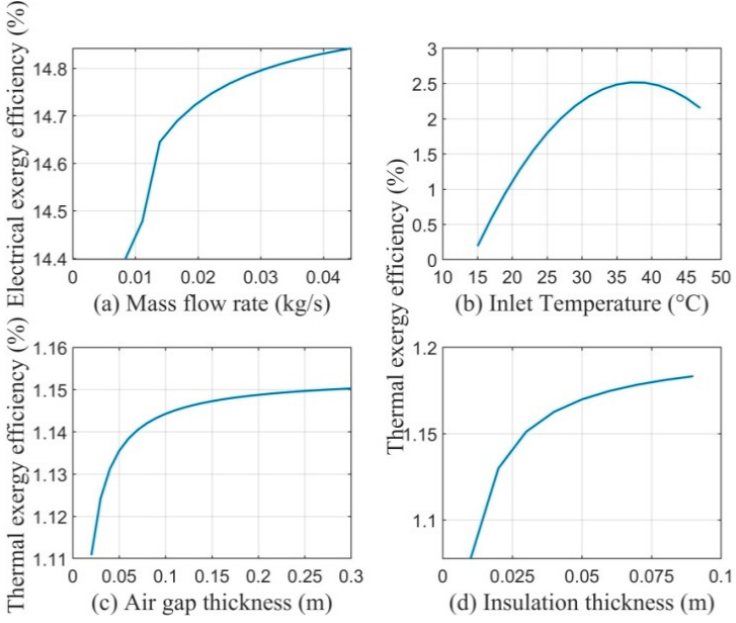
Figure 15. The sensitivity of the decision variables to electrical and thermal exergy efficiencies: ( a ) mass flow rate, ( b ) inlet temperature, ( c ) air gap thickness and ( d ) insulation thickness.